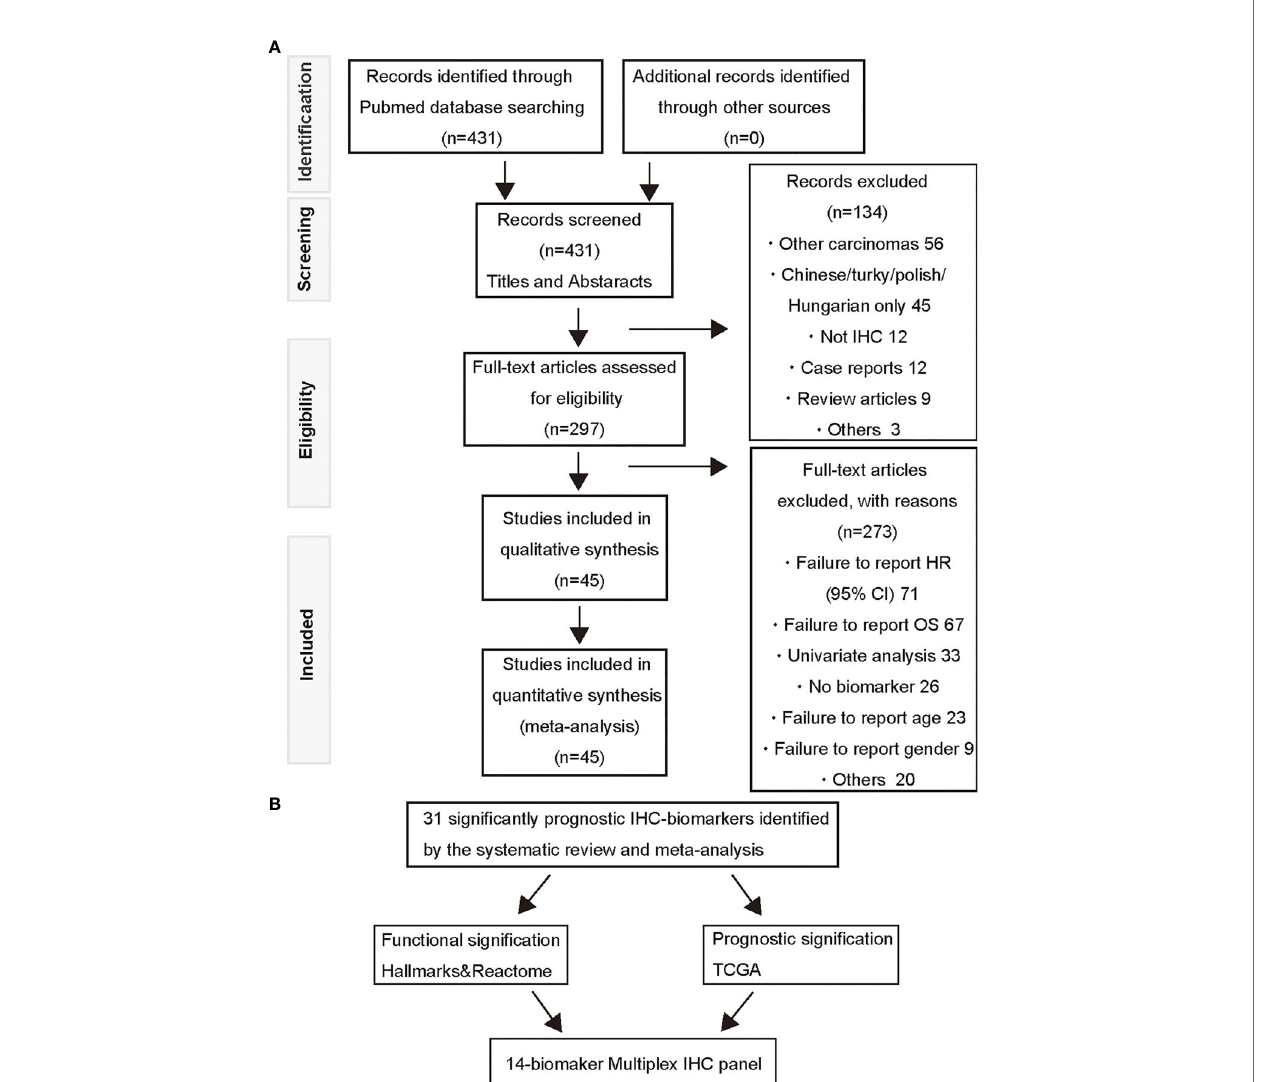
FIGURE 1 | A PRISMA fl ow diagram of the systematic review of IHC-based prognostic biomarkers and multiplex IHC panel selection. (A) A prisma fl ow diagram presents the PubMed searches, the number of manuscripts excluded, and the identi fi ed high-quality cohort studies. (B) Selection strategies based on prognostic and functional signi fi cance are applied for establishment of the 14-biomaker multiplex IHC